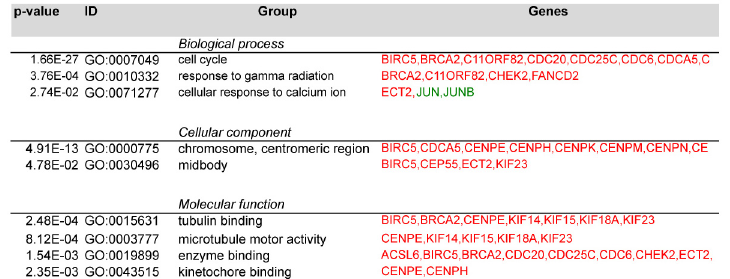
Fig 4. Single genes and relative groups identified through stringent g:Profiler analysis. g:Profiler gGOSt was set with the following parameters: i) significant only, ii) hierarchical sorting, and iii) hierarchical filtering best per parent group (strong) to identify most robustly gene groups regulated by HD-CAV-2 transduction. These include the cell cycle and DNA damage related processes, and the centromeric-related metabolism. Interestingly, several microtubule-associated molecular motors were part of the transcriptomic picture of HD-CAV-2-neurospheres. Specifically, infection with HD-CAV-2 transduction induced the modulation of multiple kinesins. In red, upregulated probes, in green, downregulated, and in grey, probes with unmodified expression with respect to mock.